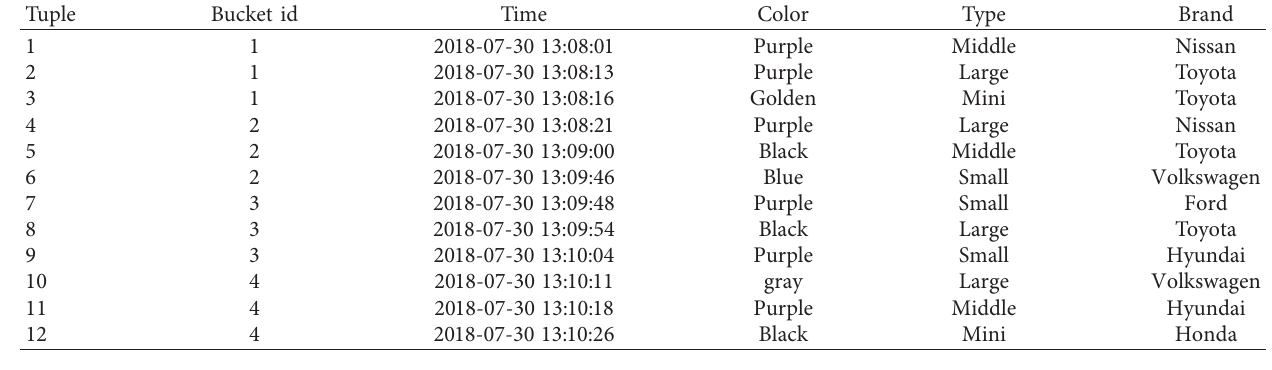
Table 3: The original VLPR data with bucked